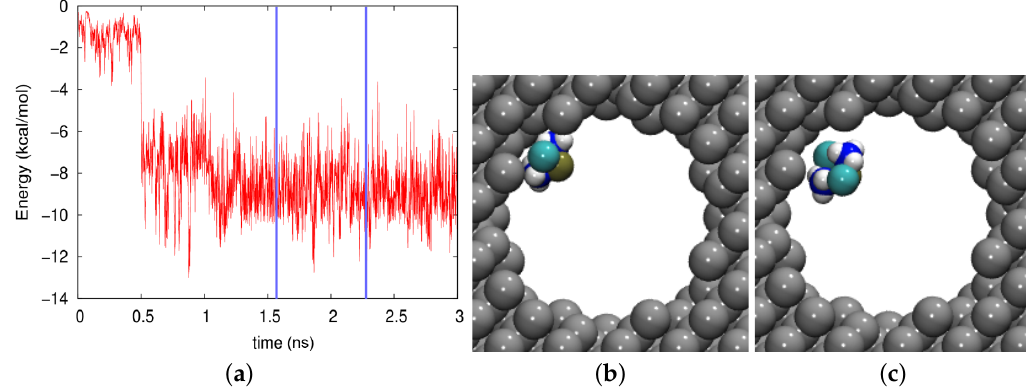
Figure 8. ( a ) Evolution of the vdW energy between the cisplatin molecule and the silicon pore during the diffusion process. ( b , c ) show snapshots at times of ( b ) 1584 ps and ( c ) 2325 ps. These times are marked in ( a ) by vertical blue